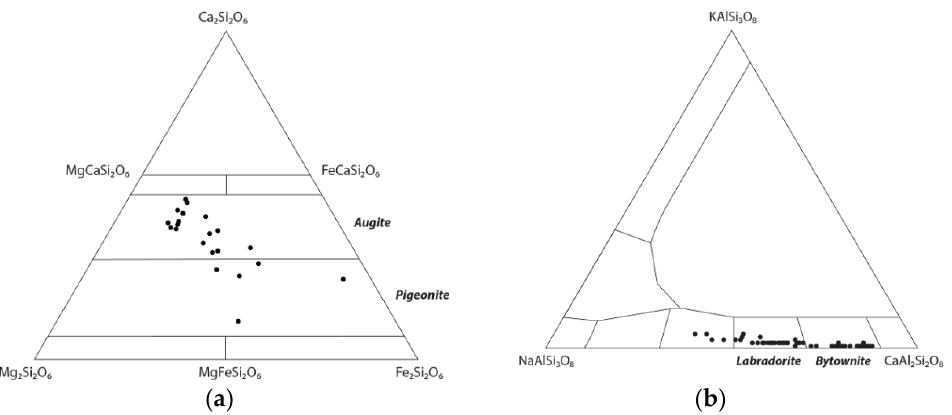
Figure 15. ( a ) Partition of clinopyroxenes from the porphyritic basalt in a ternary diagram between enstatite–wollastonite–ferrosilite endmembers. ( b ) Partition of plagioclases from the porphyritic basalt in a ternary diagram between the albite–orthoclase–anorthite endmembers.